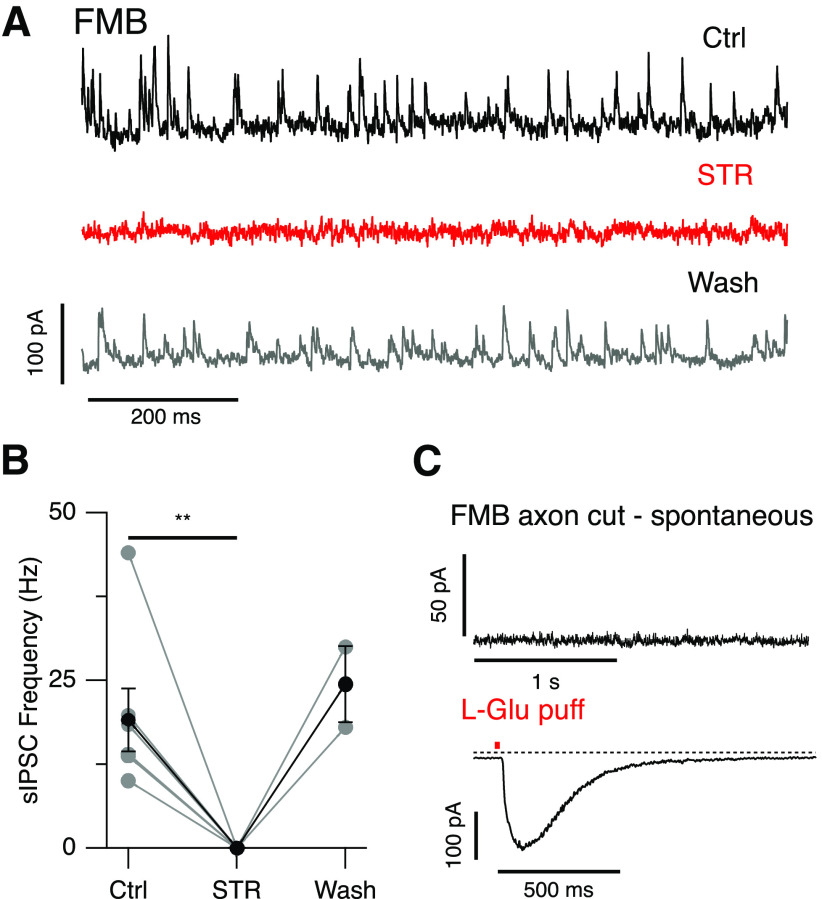
Spontaneous inhibition in FMB cells is glycinergic and arises at the axon terminals. A, Example traces from an FMB cell showing the frequency of sIPSCs before, during, and after bath application of STR (0.5 μm). Events were recorded during a voltage step to −20 mV from a holding potential of −70 mV. B, Effect of STR on sIPSC frequency for a group of FMB cells (Ctrl and STR; n = 7 cells, washout; n = 2 cells, **p = 0.004, Wilcoxon signed-rank test). Gray points indicate individual cells, black points indicate mean ± SEM. C, top panel, Example trace showing a lack of spontaneous events in an axotomized FMB cell during a voltage step to −20 mV from −70 mV. Bottom panel, Current response to a 20-ms puff application (red bar) of L-glutamate (1 mm) applied to the same cell. The presence of a glutamate-evoked inward current confirms the Off-type physiology of the axotomized midget cell. Holding potential is −70 mV.